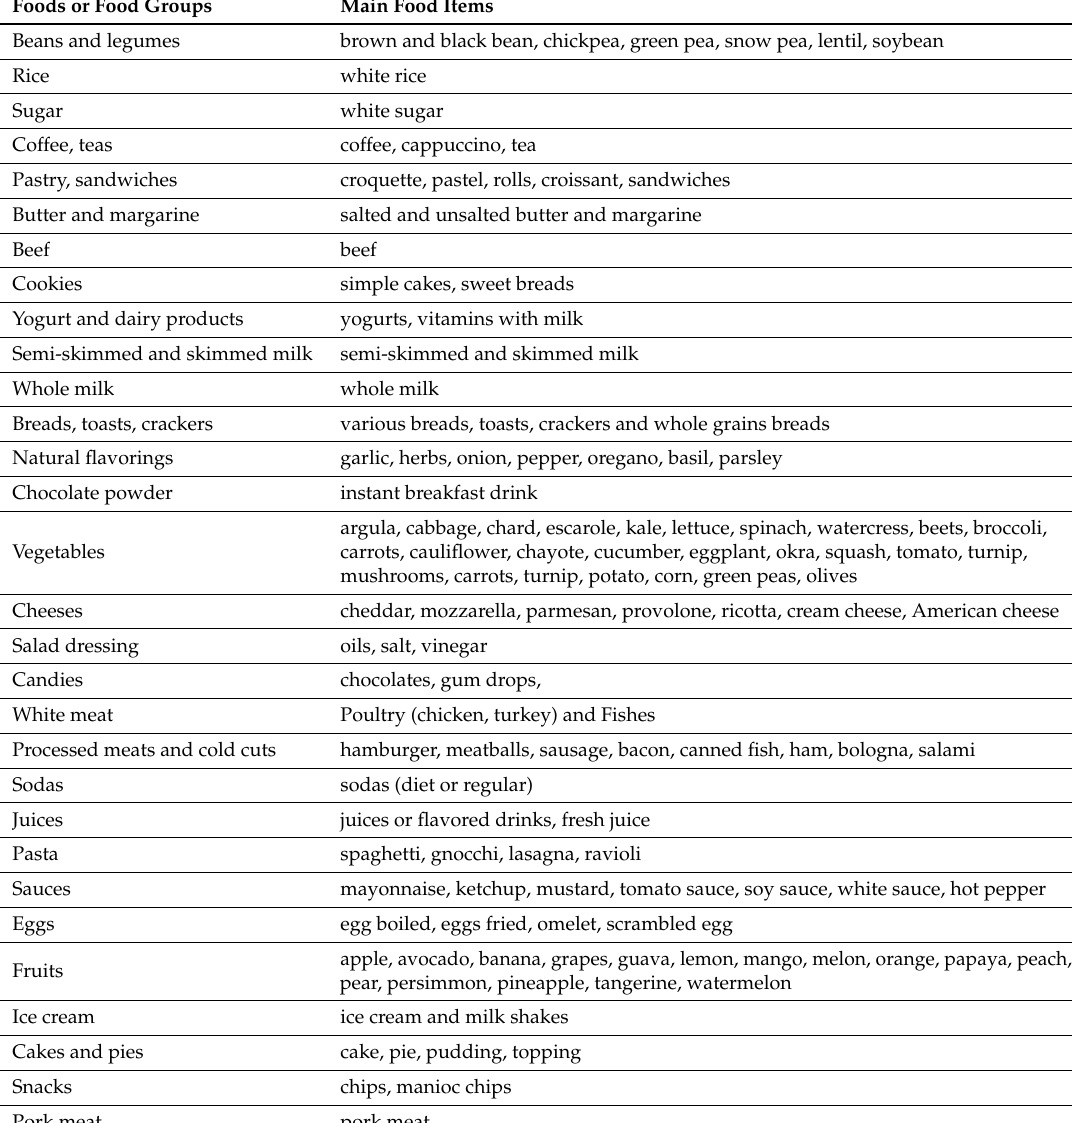
Table 1. Foods and food groups included in factor analysis. São